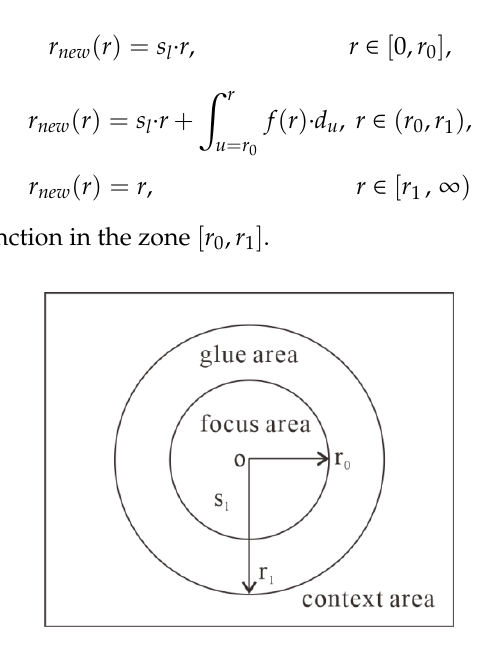
Figure 2. division of the variable-scale map. Figure 2. Division of the variable-scale